Question: What kind of plot is shown here?
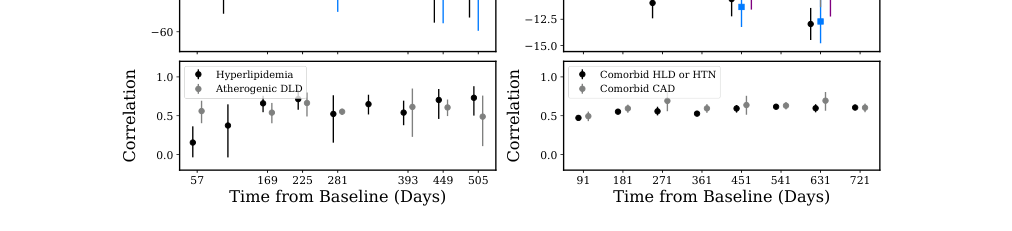
Answer: bar